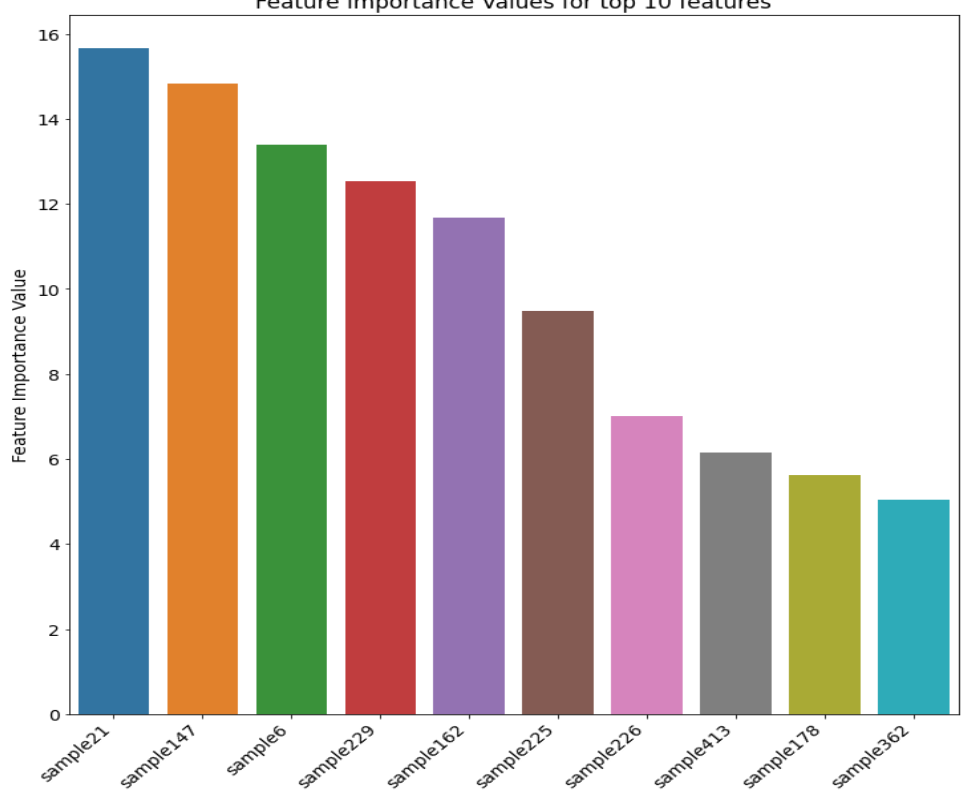
Figure 12. Top 10 Features (samples) positively influencing the spatial estimation process in Walkerlake dataset.